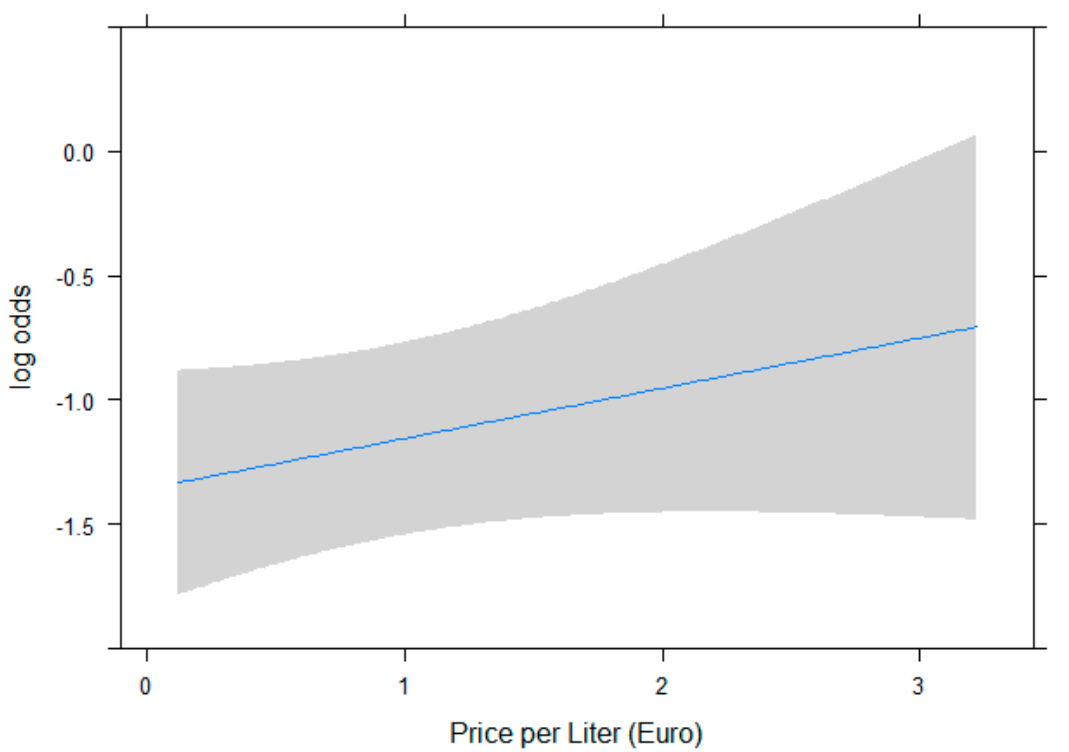
Figure 1. Association between price of water and risk of “uncertain” claim. Association is not statistically significant (OR for a 0.5 € increase is 1.10, 95% C.I. 0.955–1.280).